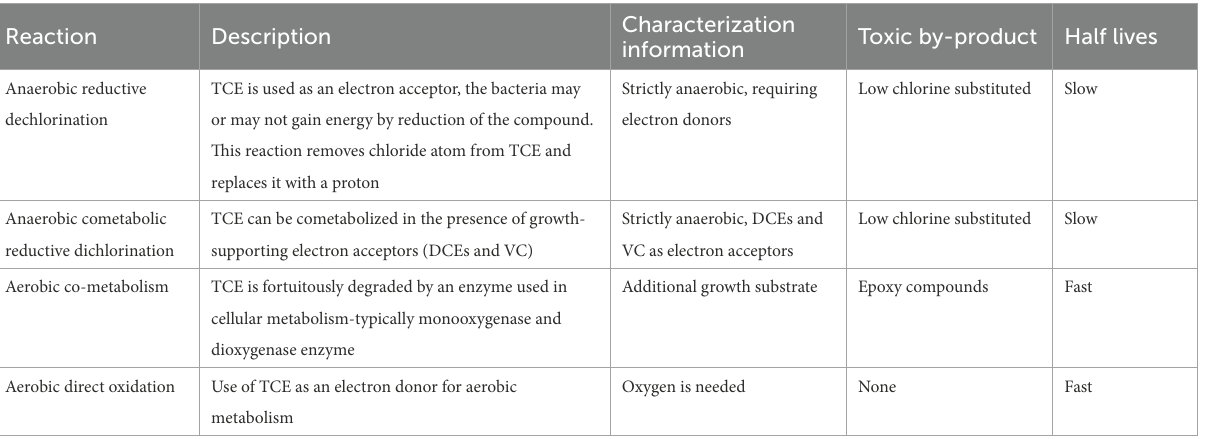
TABLE 2 Characteristics of four types of biodegradation process of